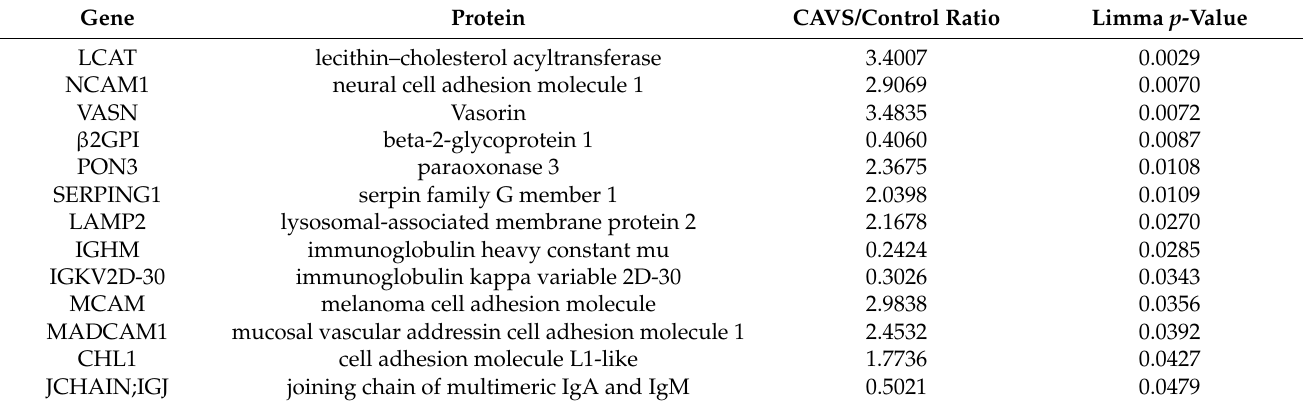
Table 2. List of proteins found to be differentially associated between Lp(a) of subjects with aortic stenosis compared to healthy